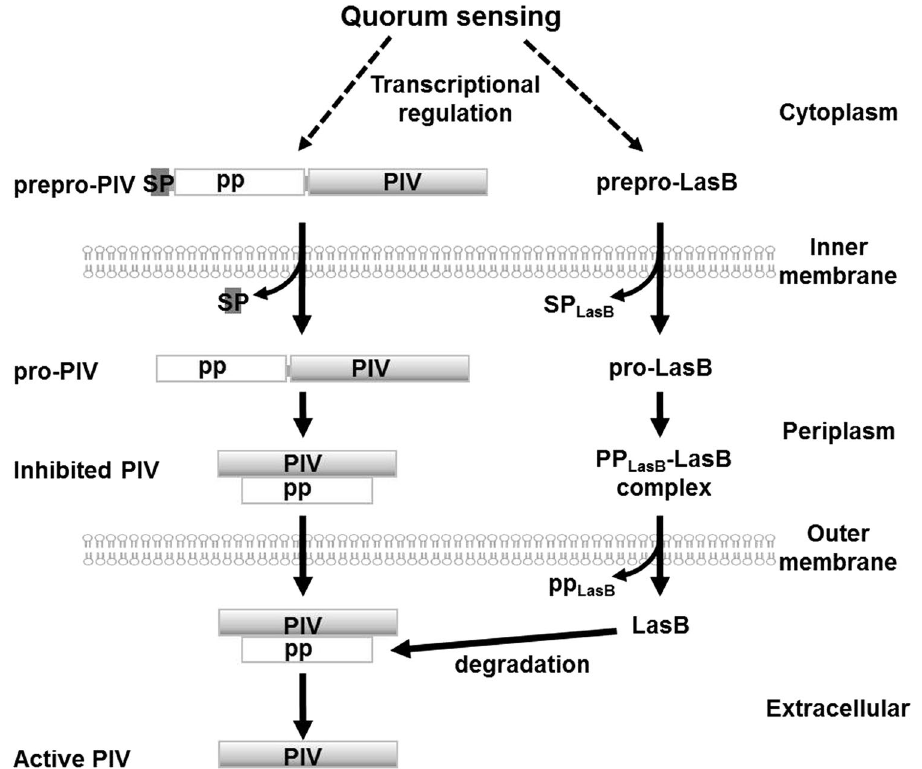
Figure 6. QS-mediated post-secretional activation of PIV. The initial expression of both PIV and LasB is positively regulated by QS. The prepro-PIV in cytoplasm is processed twice from N-terminus during secretion to release signal peptide, propeptide, and mature PIV in extracellular space. The mature PIV is inhibited by the propeptide binding. The mature LasB then degrades the propeptide to release activate PIV. LasB is also processed in a similar manner and inhibited by its propeptide (PP LasB ). The processing of pro-LasB to mature LasB is achieved by auto-cleavage. SP, signal peptide; PP,